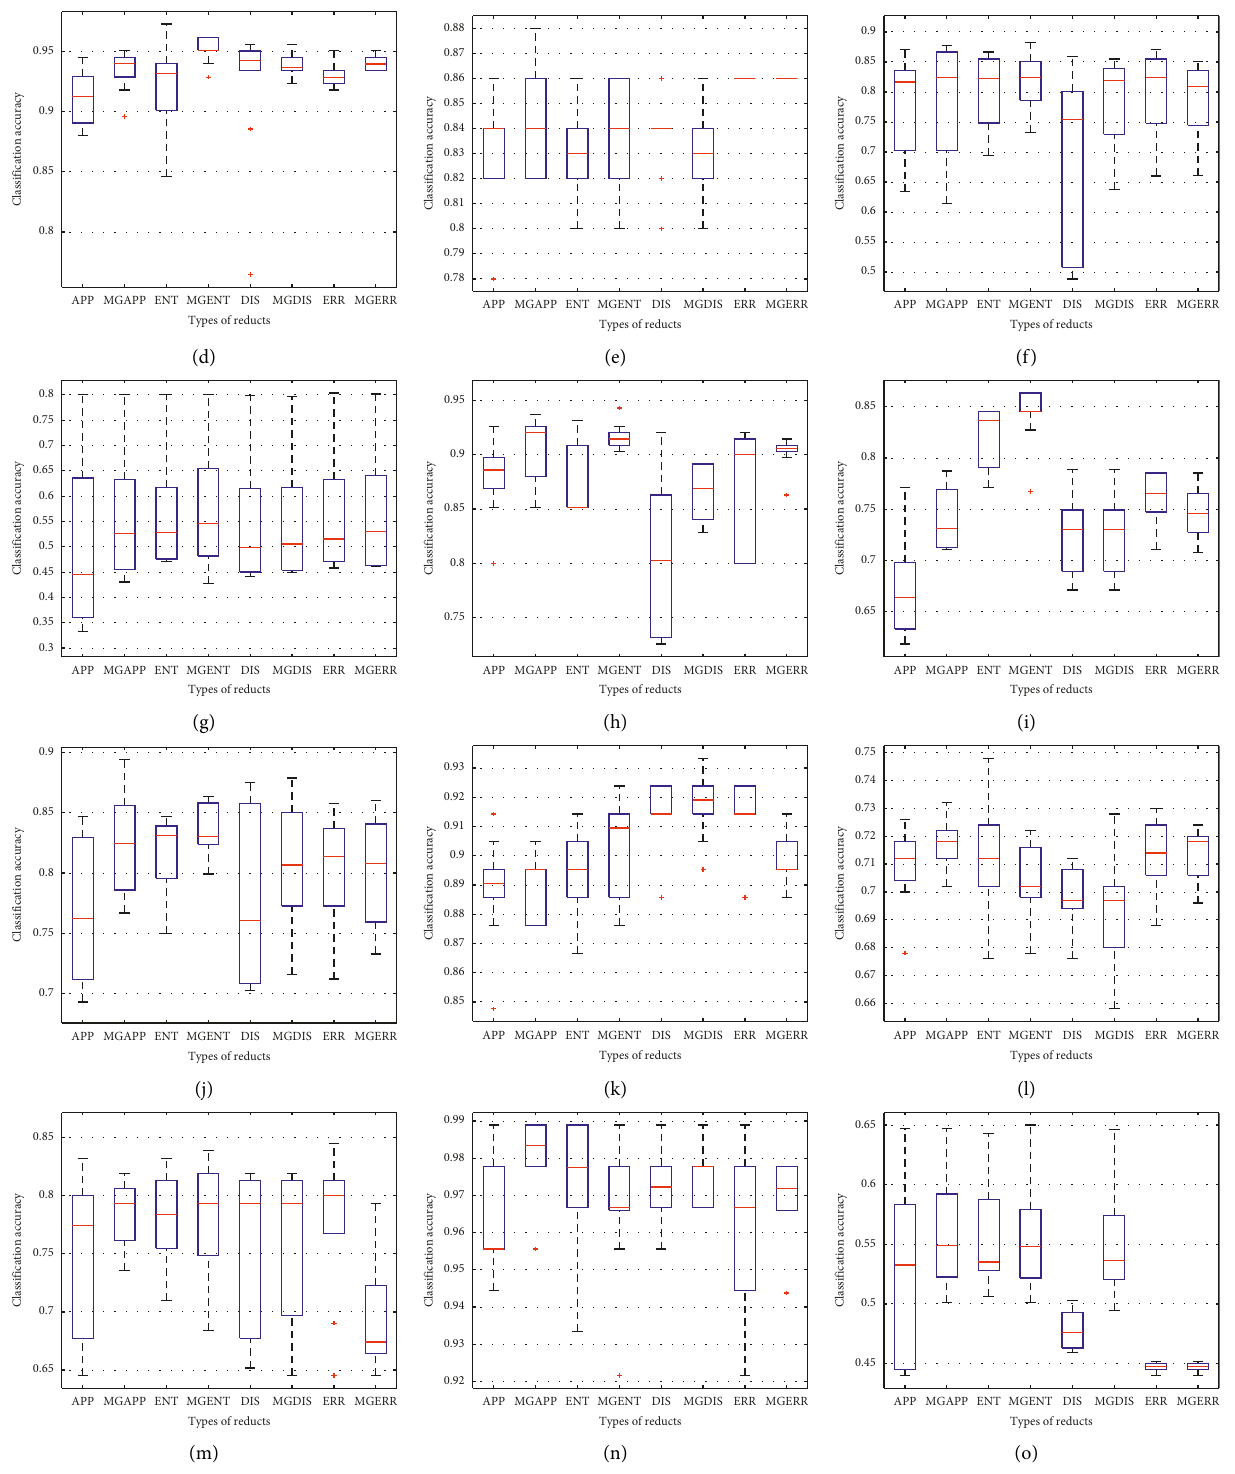
Figure 2: Comparisons among the classification accuracies with using NEC. (a) Breast Cancer Wisconsin (Diagnostic). (b) Breast Tissue. (c) Climate Model Simulation Crashes. (d) Dermatology. (e) Fertility. (f) Forest Type Mapping. (g) Gesture Phase Segmentation. (h) Ionosphere. (i) Molecular Biology (Promoter Gene Sequences). (j) QSAR Biodegradation. (k) Seeds. (l) Statlog (German Credit Data). (m) Vertebral Column. (n) Wine. (o) Wine